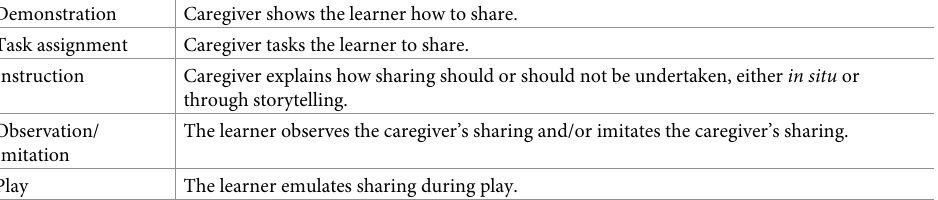
Table 1. Description of teaching and learning categories used to code the interview responses, adapted from Hew- lett and Roulette [86].